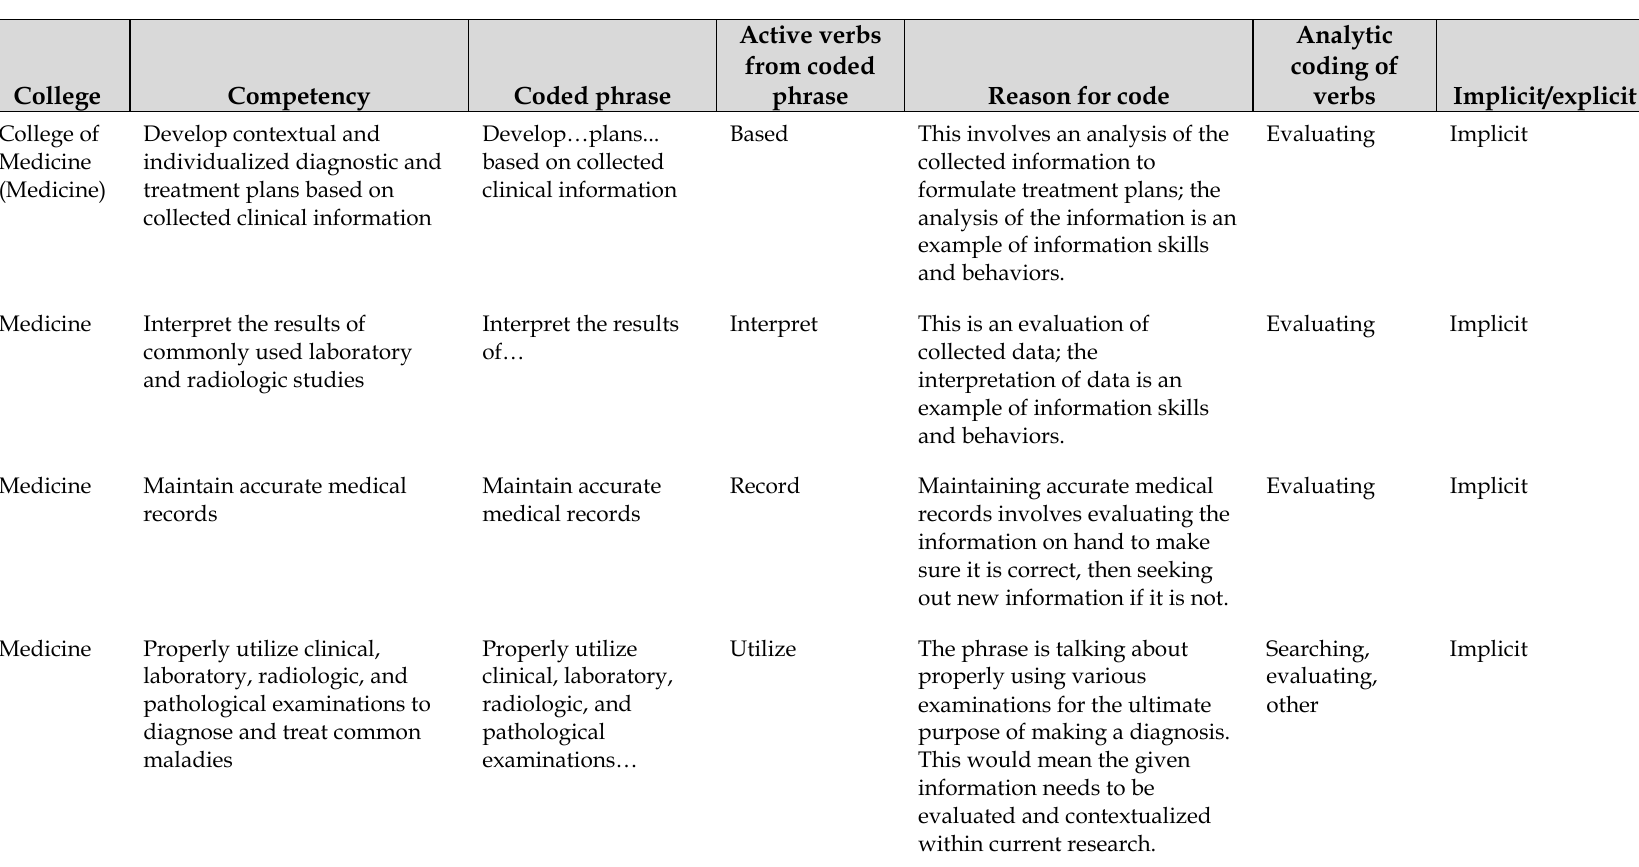
Table 2 Competencies with implicit or explicit information skills and